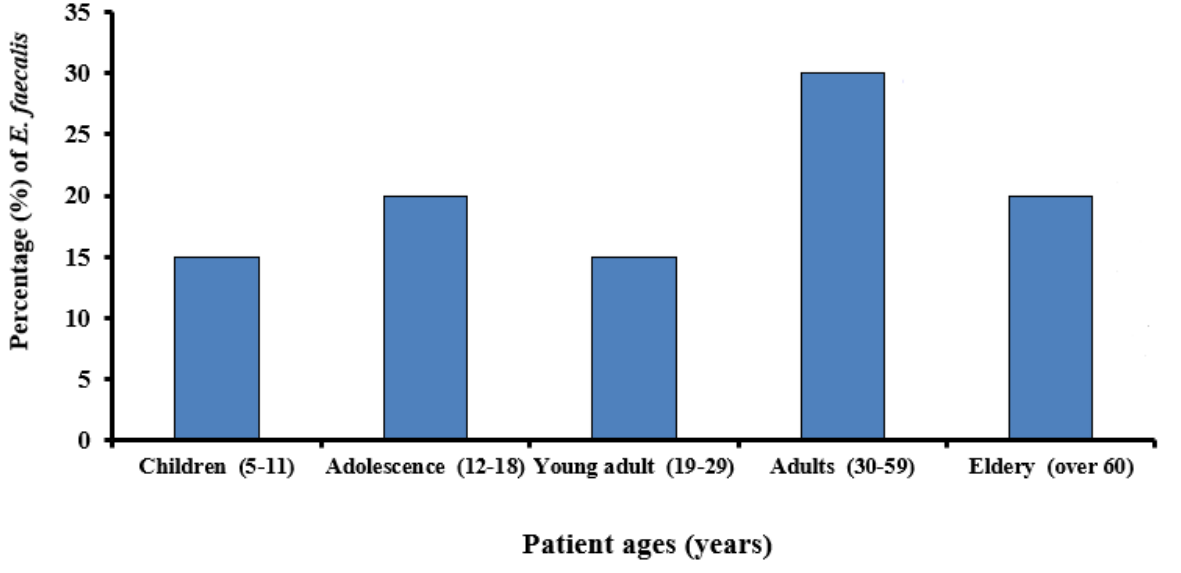
Figure 1. Age distribution of oral carriers of E. faecalis .